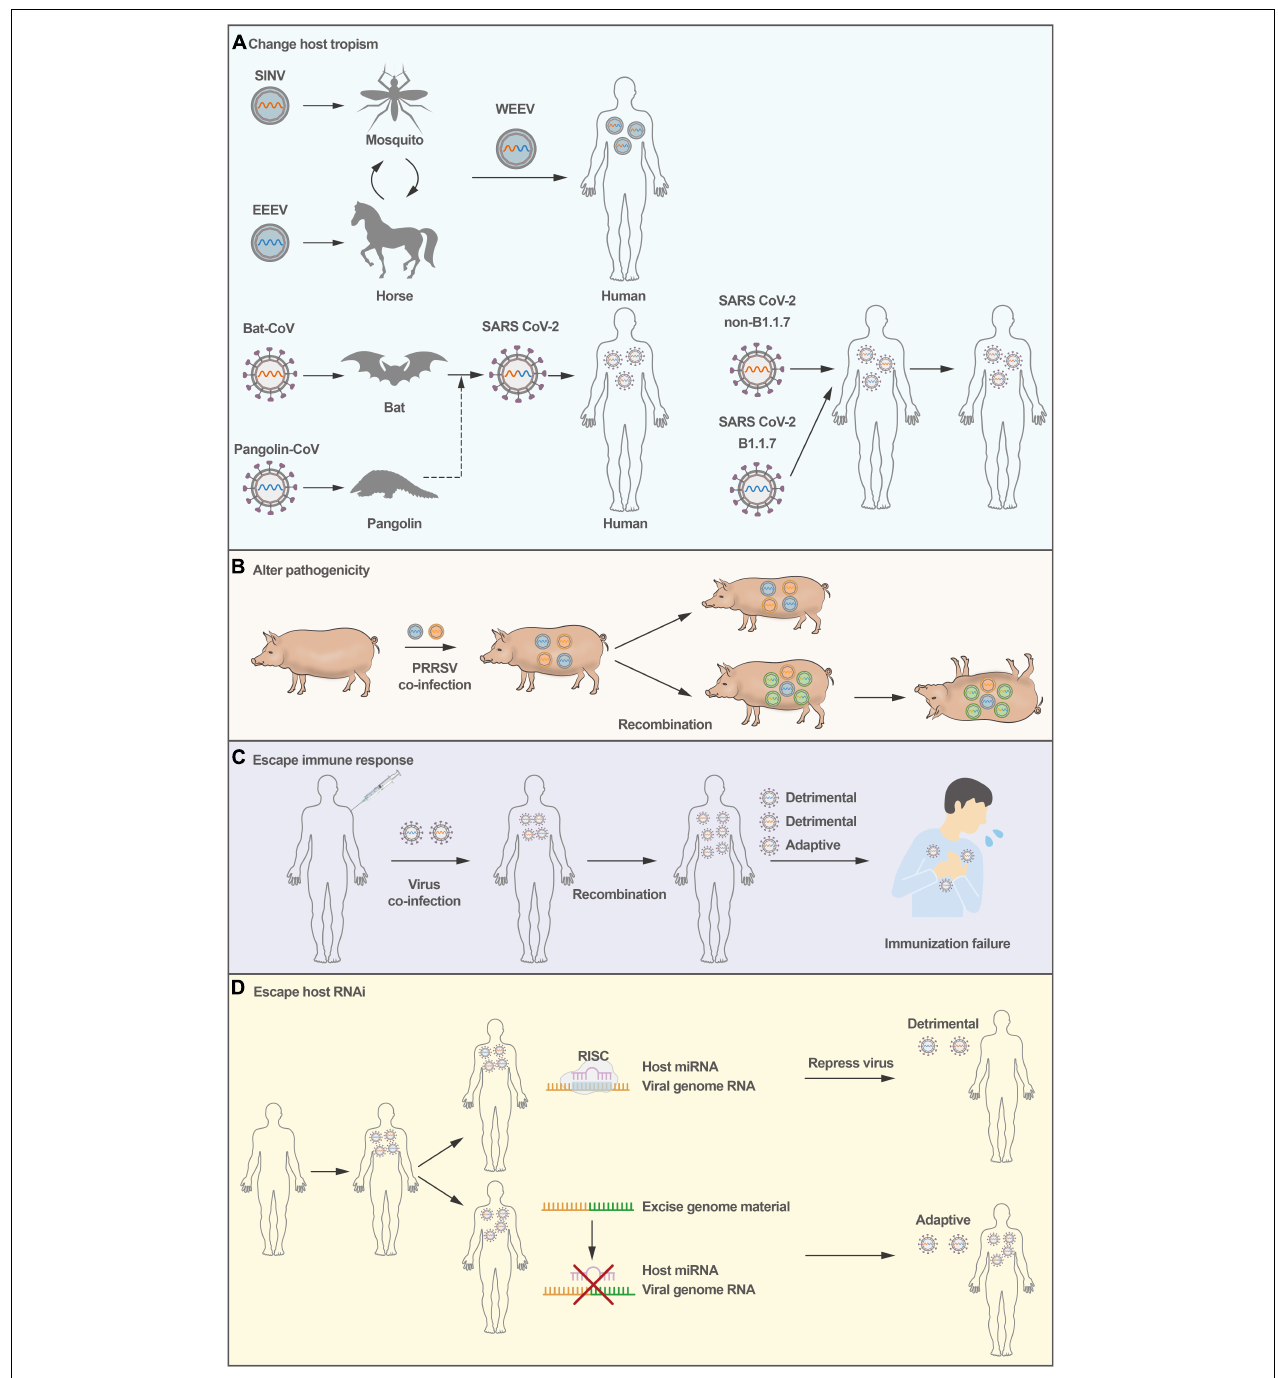
FIGURE 1 | Consequences of virus recombination. (A) Virus recombination causes host species expansion; WEEV and SARS-CoV-2 were transferred from animals to humans via recombination. (B) PRRSV recombination causes pathogenicity alterations in pigs. (C) Virus recombination makes the virus escape immunity, and the replication of the virus in the host eventually results in immunological failure. (D) RNA viruses could excise genomic material through recombination as an intrinsic defense against antiviral RNA